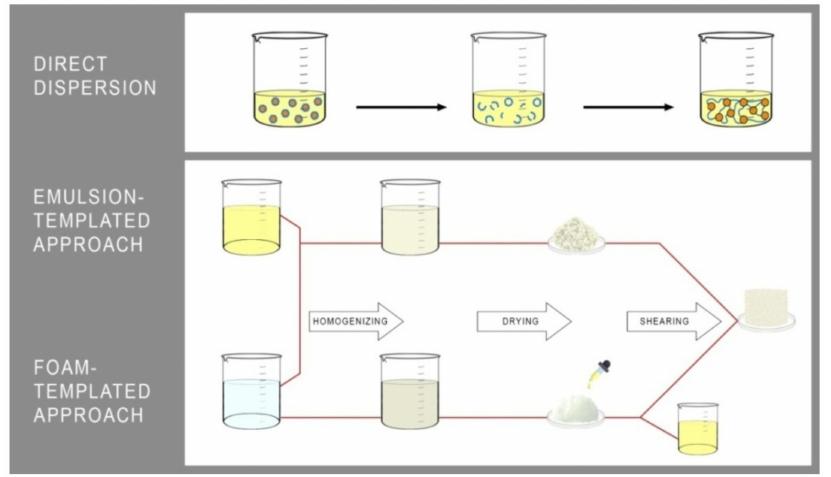
Figure 2. The leading strategies used for oleogels